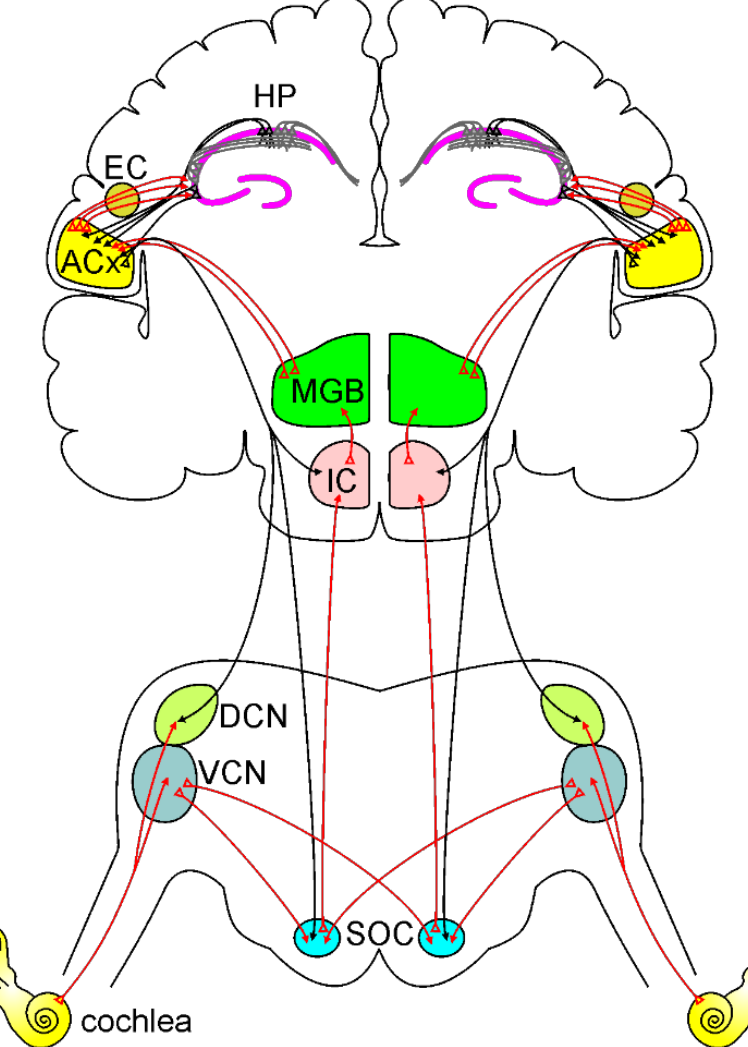
Figure 1. Ascending and descending auditory pathways.